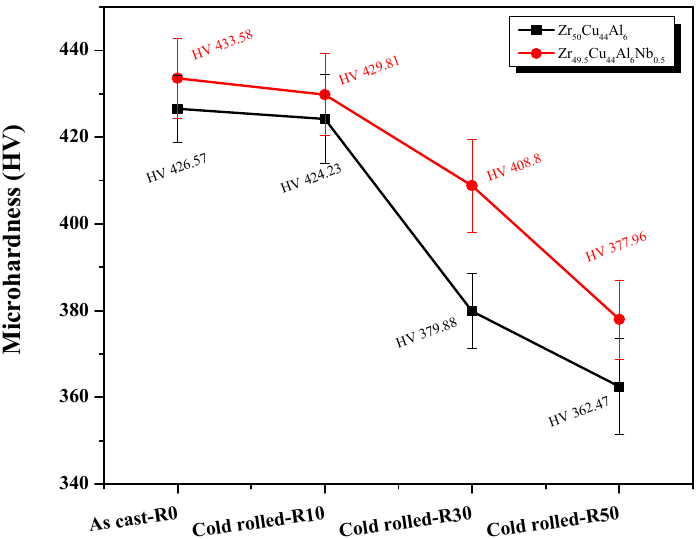
Figure 5. Micro-hardness of samples at different plastic